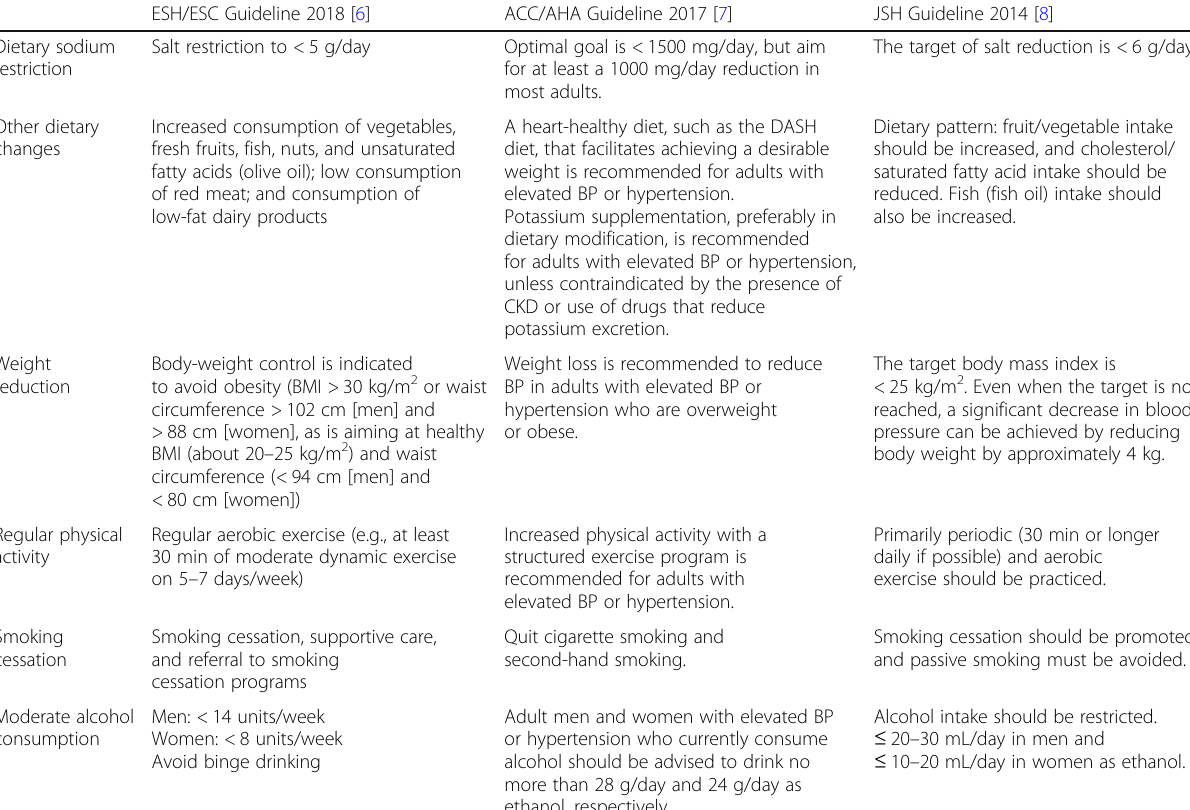
Table 1 Comparison between three major lifestyle modifications in the hypertension